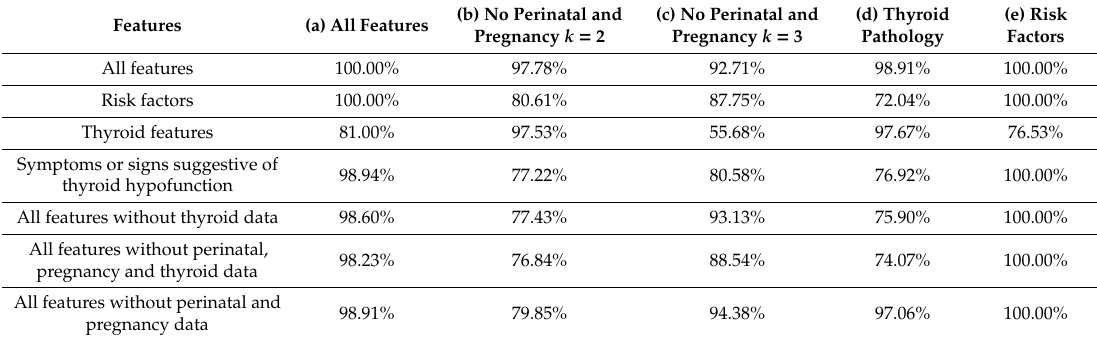
Table 8. RF accuracy using seven sets of